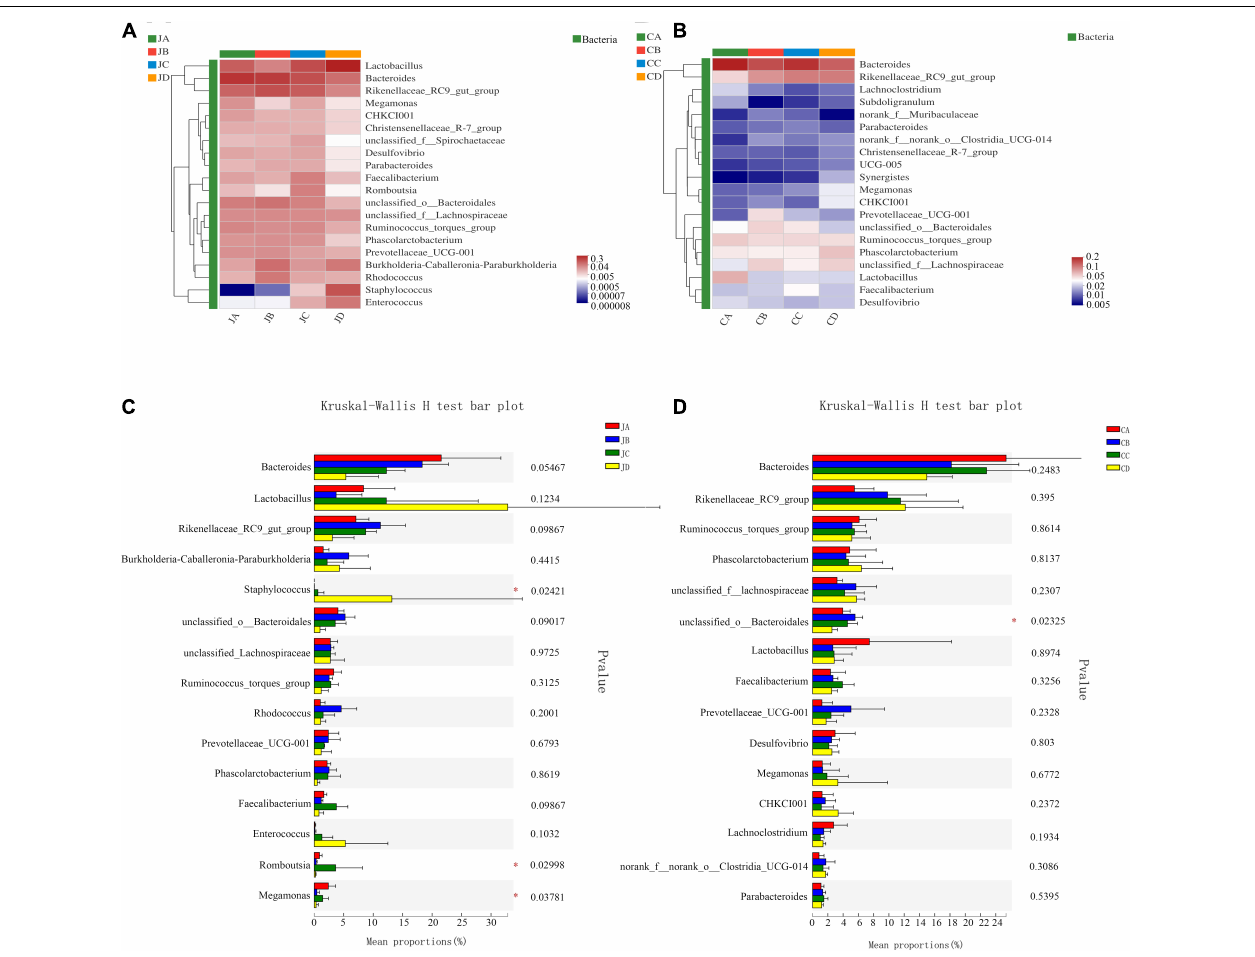
FIGURE 5 | Heatmap chart of the top 20 genera in different intestinal segments ( A : jejunum; B : cecum) and comparison of differences between groups of the top 20 phyla ( C : jejunum; D : cecum). One-way analysis of variance, JA, jejunum of 0% HILM; JB, jejunum of 1% HILM; JC, jejunum of 3% HILM; JD, jejunum of 5% HILM; CA, cecum of 0% HILM; CB, cecum of 1% HILM; CC, cecum of 3% HILM; CD, cecum of 5%